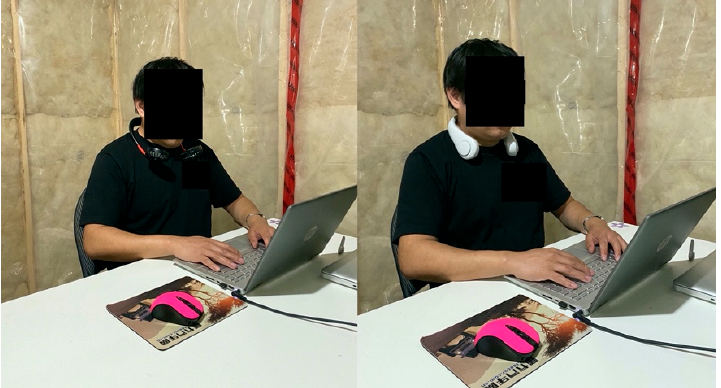
Figure 1. Facial cooling fan ( Left image ) and neck cooling fan ( Right image).